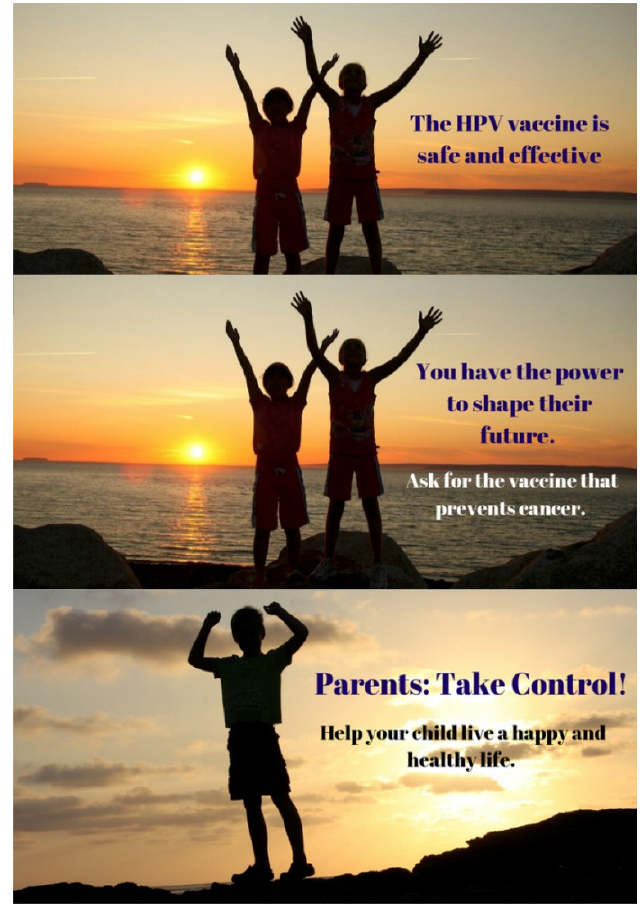
Figure 1. Top three performing ads.